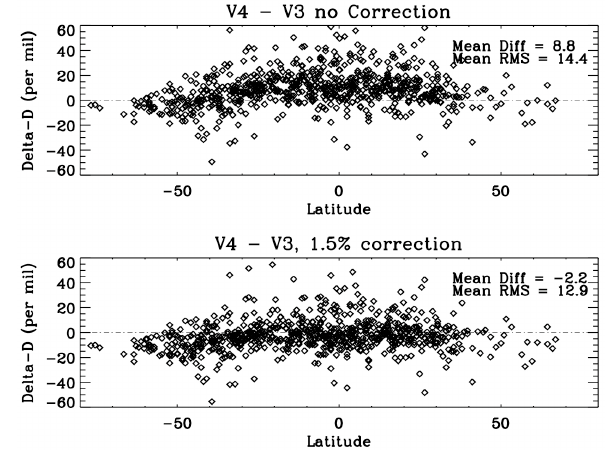
Fig. 8. Comparison between V4 and V3 of the TES HDO/H 2 O ra- tios, averaged between 825 and 500hPa. The bottom panel includes Figure 7. Comparison between V4 and V3 of the TES HDO/H a 1.5% correction to V4, modified by the HDO averaging between 825 and 500 hPa. The bottom panel includes a 1.5% correction to V4, modified by the HDO averaging kernel.